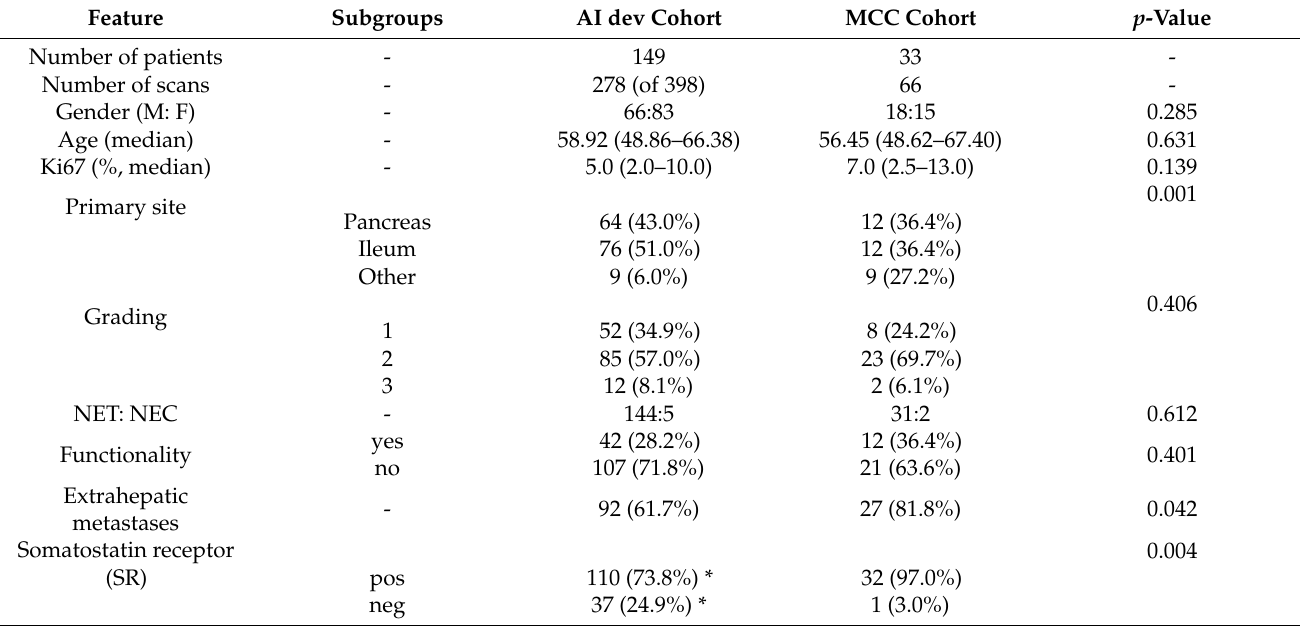
Table 1. Patient and disease characteristics of the AI dev cohort and MCC